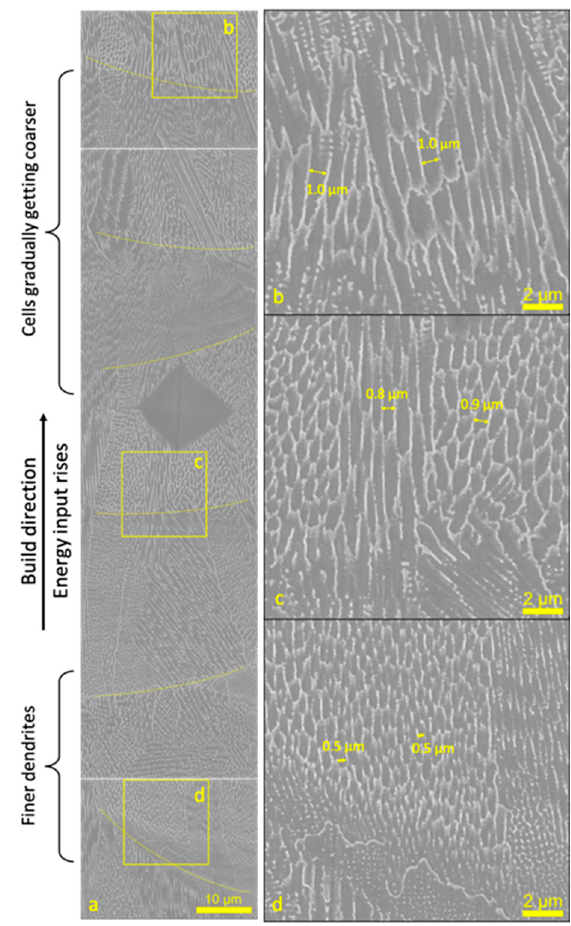
Figure 4. SEM images of the x-z section of the sample, ( a ) an assembly along the build direction showing several layers of melt pools; ( b ), ( c ) and ( d ) magnified